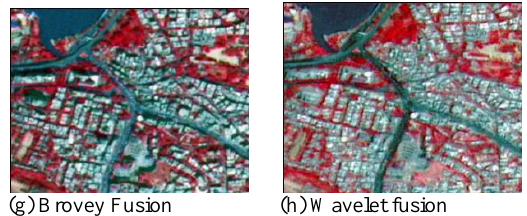
Figure 5: Zoomed around Hyderabad scene Tankbund